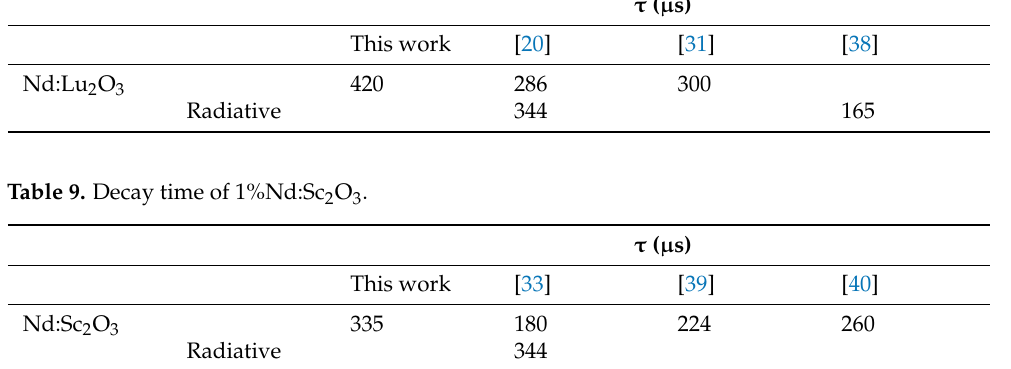
Table 7. Decay time of 1%Nd:Y 2 O 3 .